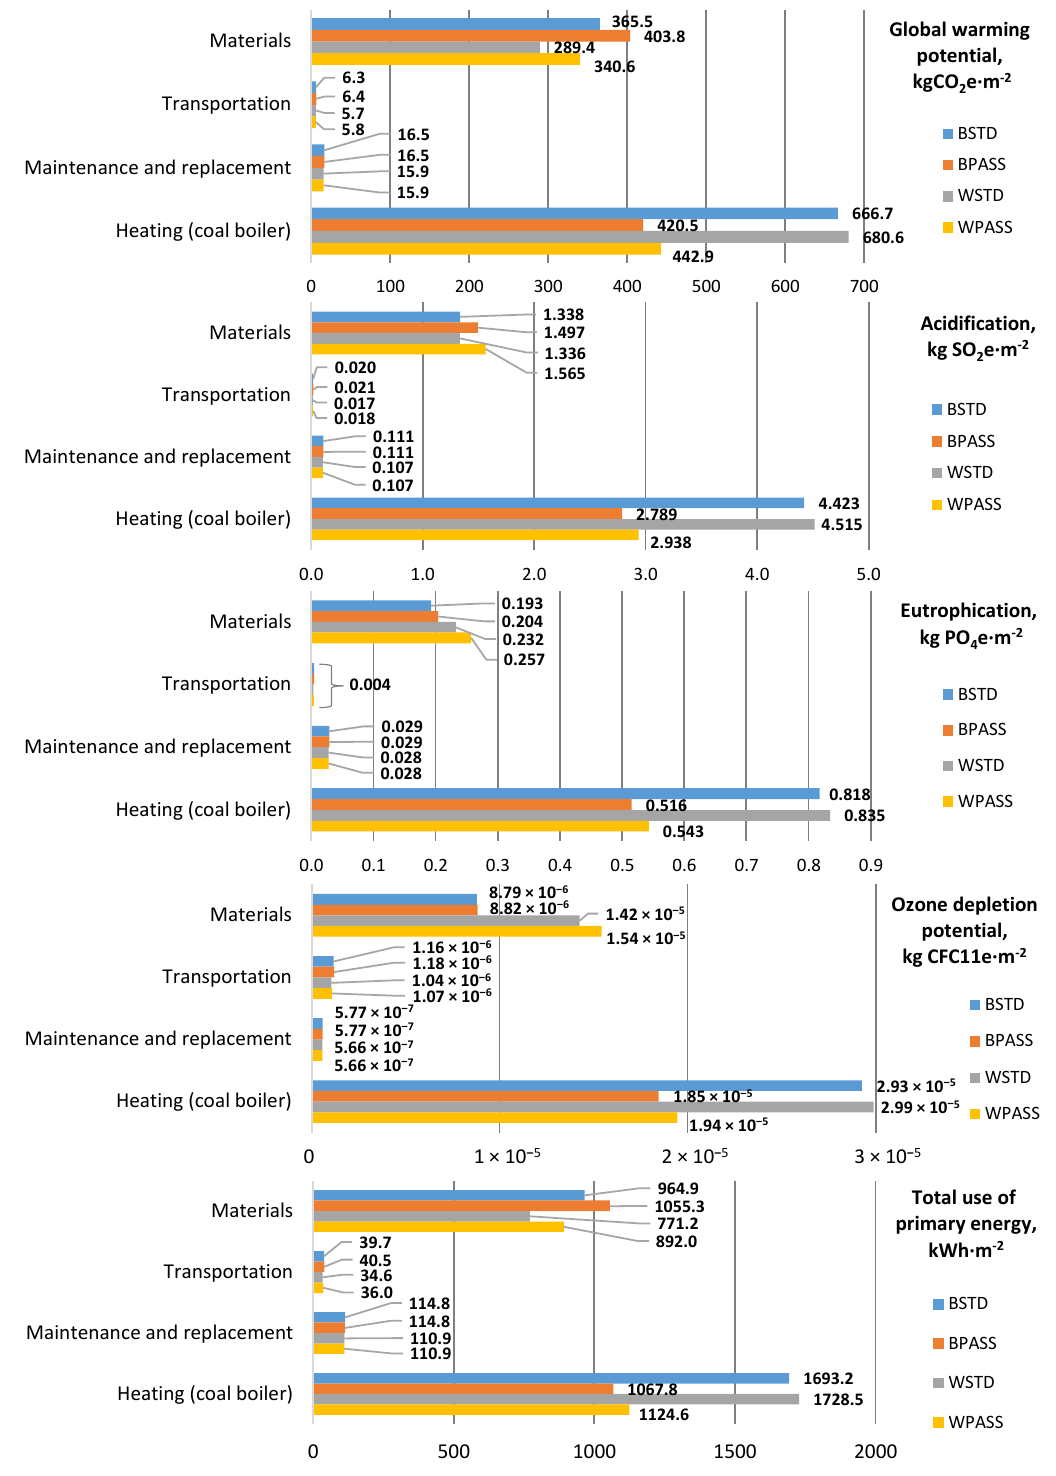
Figure 8. Global warming potential, acidification, eutrophication, ozone depletion potential, and total use of primary energy by LCA stage.